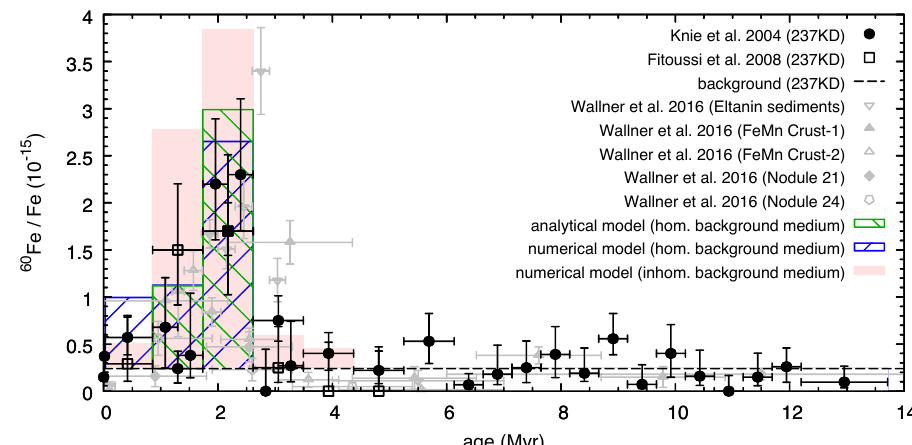
age (Myr) Figure 3. Comparison of the measured (symbols with error bars) and calculated (histograms) 60 Fe/Fe ratio as a function of the terrestrial archive’s layer age. Modeled data is set upon the instrumental background derived specifically for deep-sea crust sample 237 KD, which is indicated by the dashed